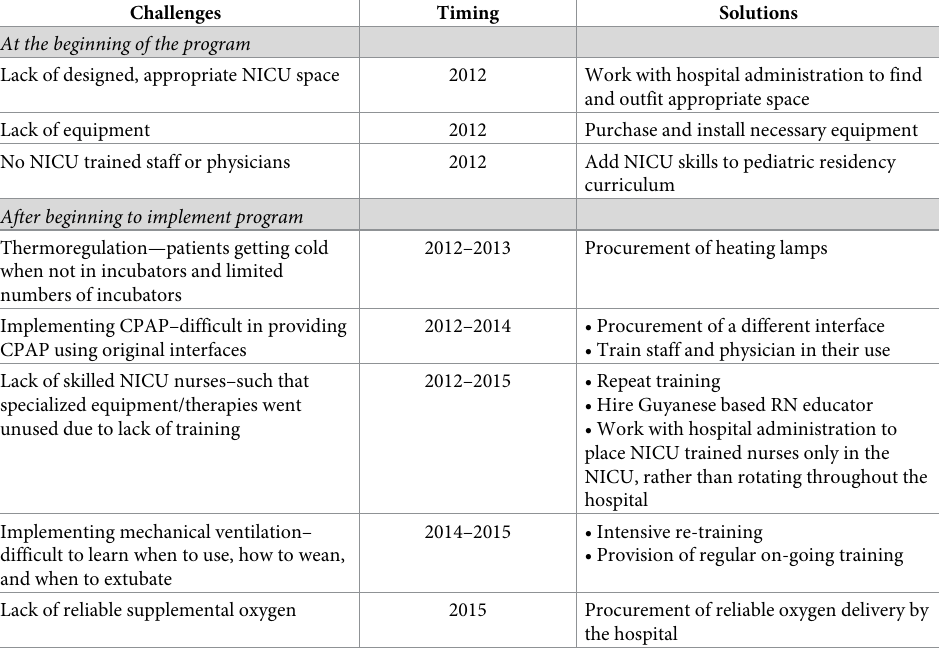
Table 1. Challenges in implementation of a Level III NICU at